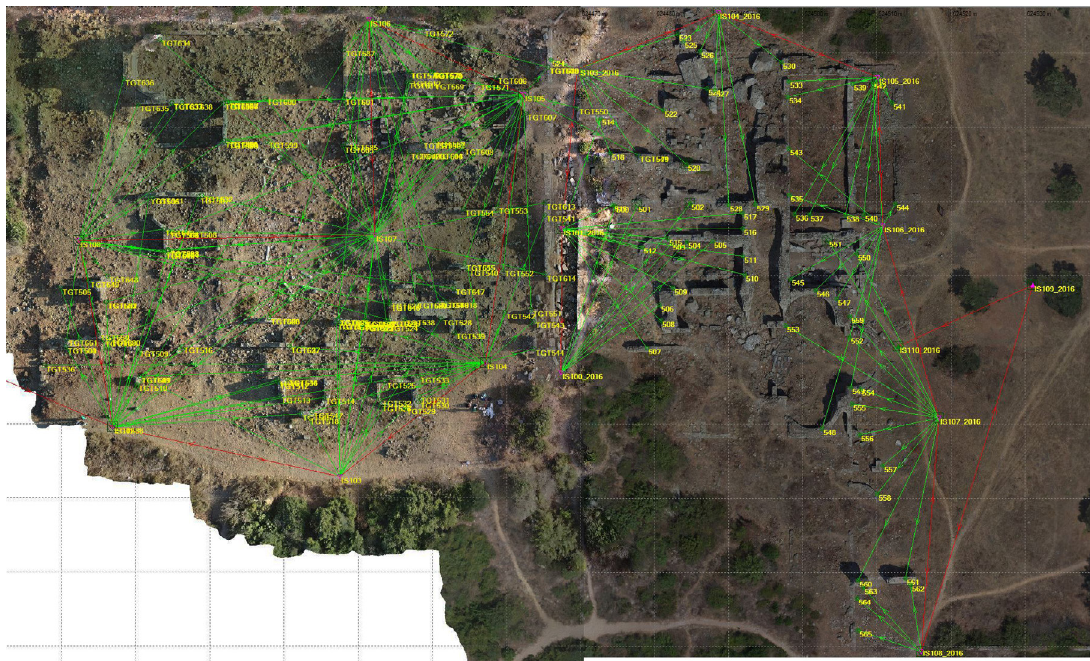
Figure 6. 2016/2018 GCPs network over an orthomosaic generated in Agisoft Photoscan 1.4.4 © ÖAW/IKAnt (M. Hernández